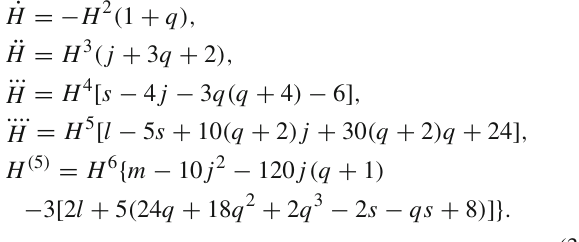
cosmological constant with different values of equation of states and the viscous dark energy model. The viscous dark energy model with γ < γ × belongs to phantom like dark energy. In mentioned figure, solid lines represents Om ( z ) for cosmological constant. Dashed and dashed-dot lines repre- sents Om ( z ) for Λ CDM with w = − 0 . 90 and w = − 1 . 20, respectively. Think solid line with corresponding 1 σ con- fidence interval determined by JLA observation represents Om ( z ) for the viscous dark energy model for γ = 0 . 14. A long-dashed line corresponds to γ = 0 . 60 demonstrating behavior during the evolution of the